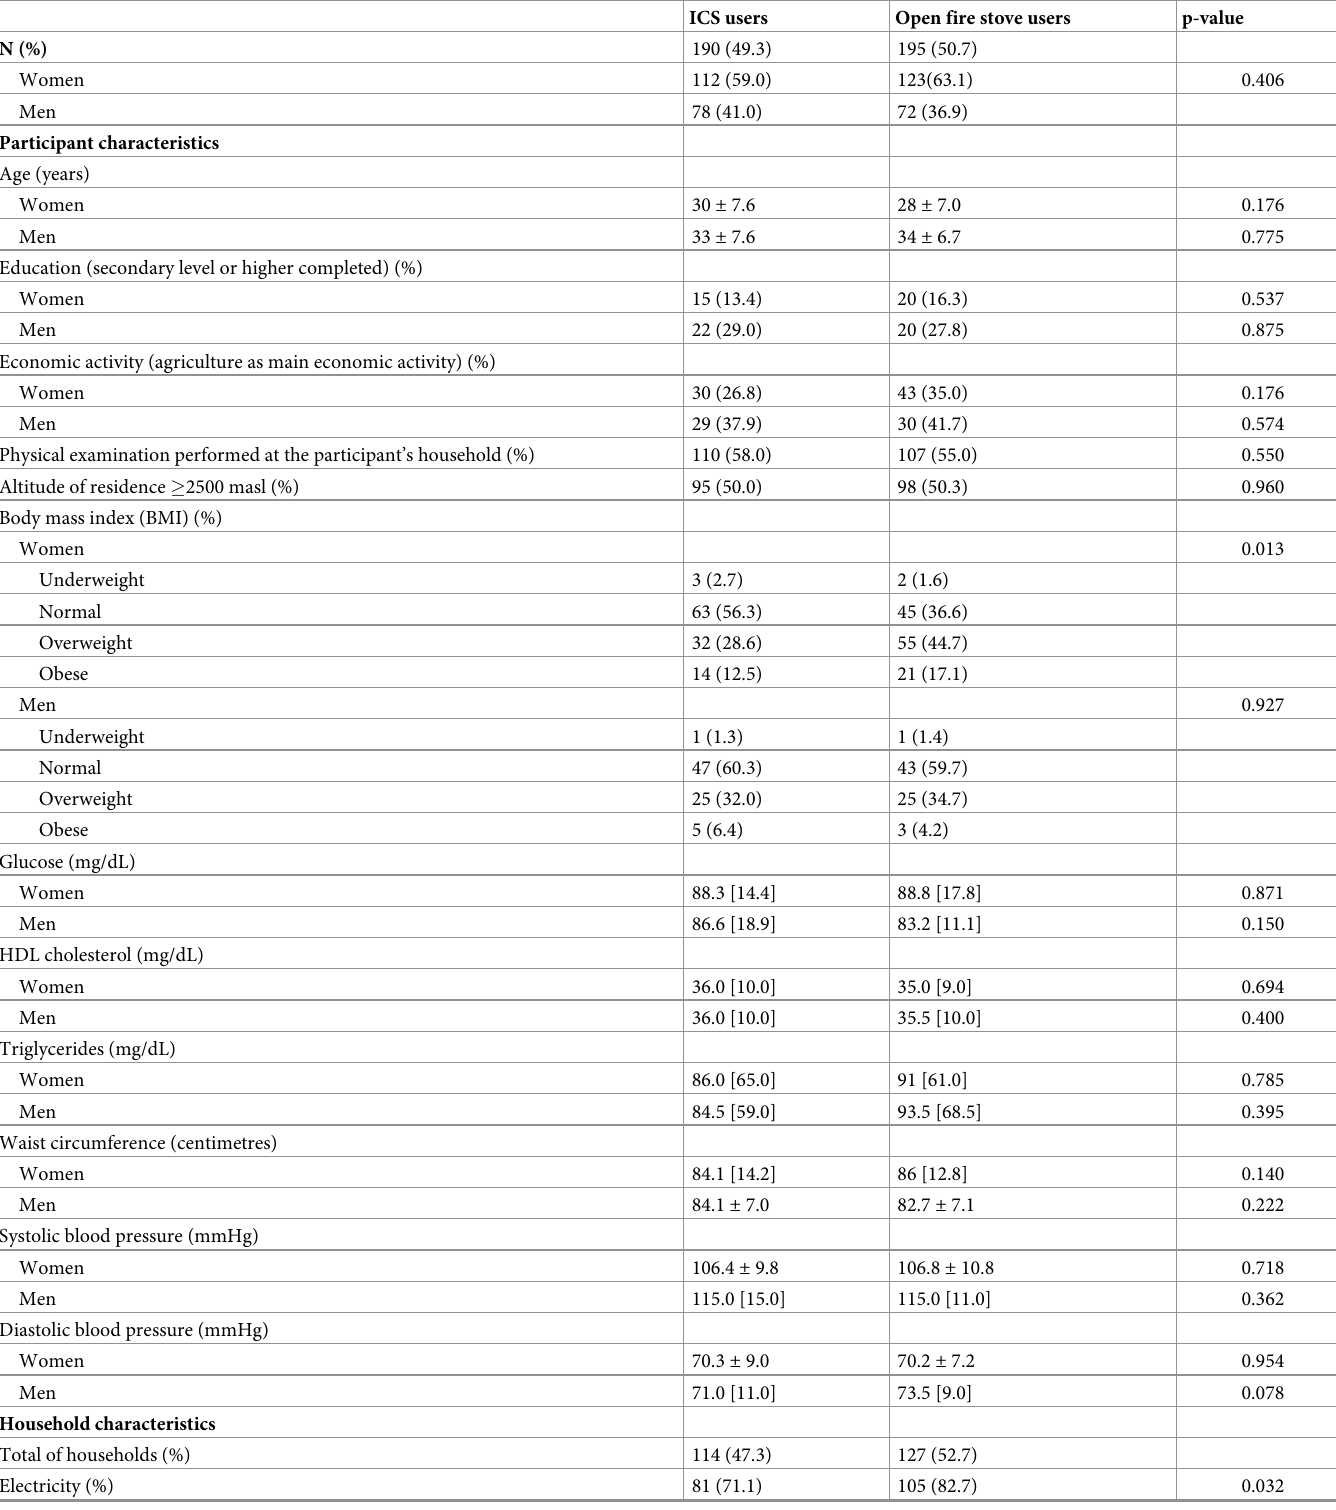
Table 1. Sociodemographic and household characteristics of adult participants of the provinces of San Marcos and Cajabamba,